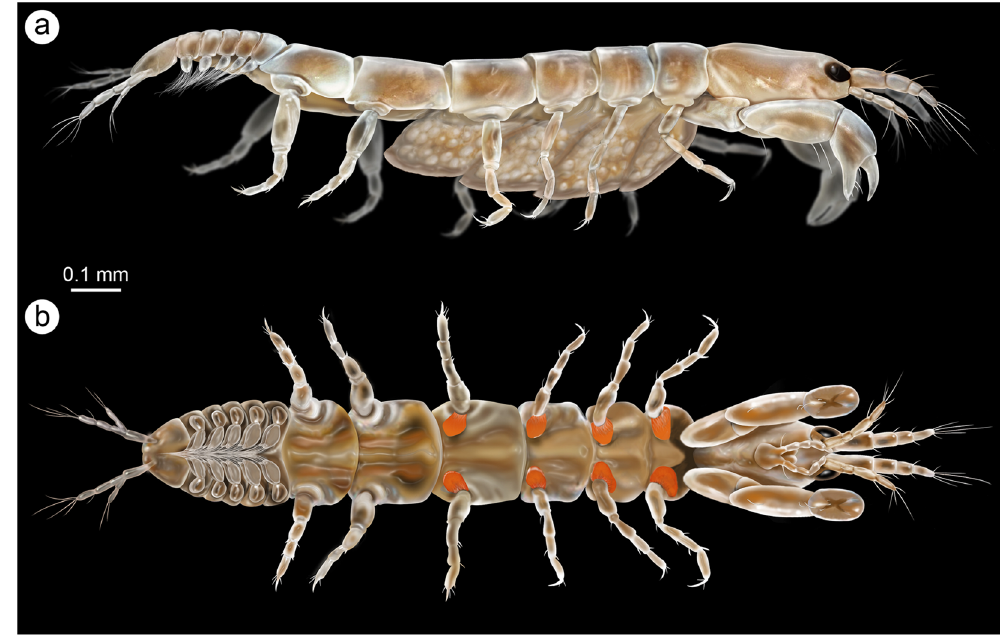
Figure 4. Reconstruction of an adult female of Alavatanais margulisae based on the holotype from Peñacerrada I amber (Álava, Spain), and to show its habitus in two different developmental stages. ( a ) Hypothetical ovigerous stage in lateral habitus. ( b ) Preparatory stage in ventral habitus. Illustrations by J.A. Peñas with scientific